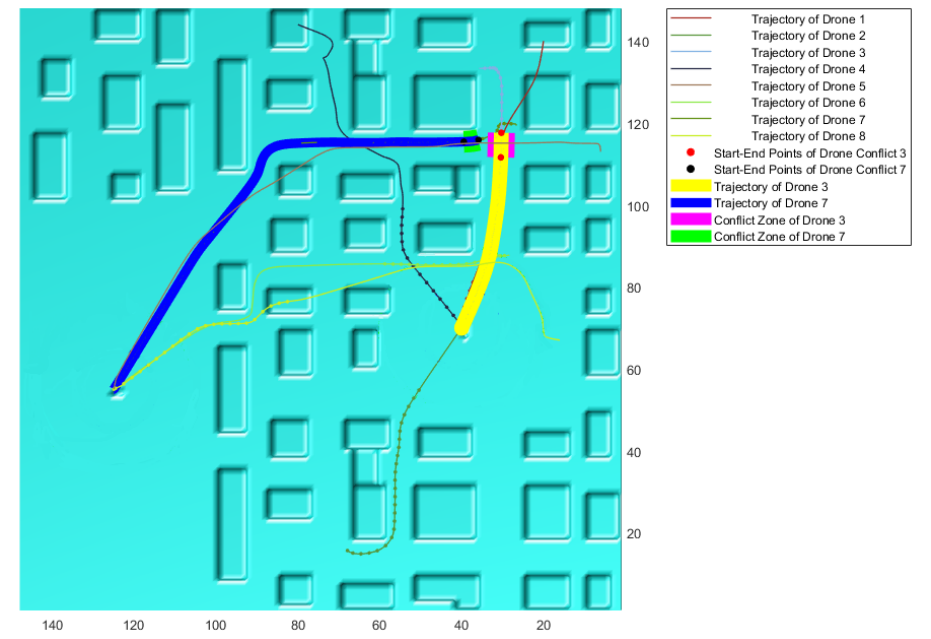
Figure 6. Example of the representation of information of a new conflict